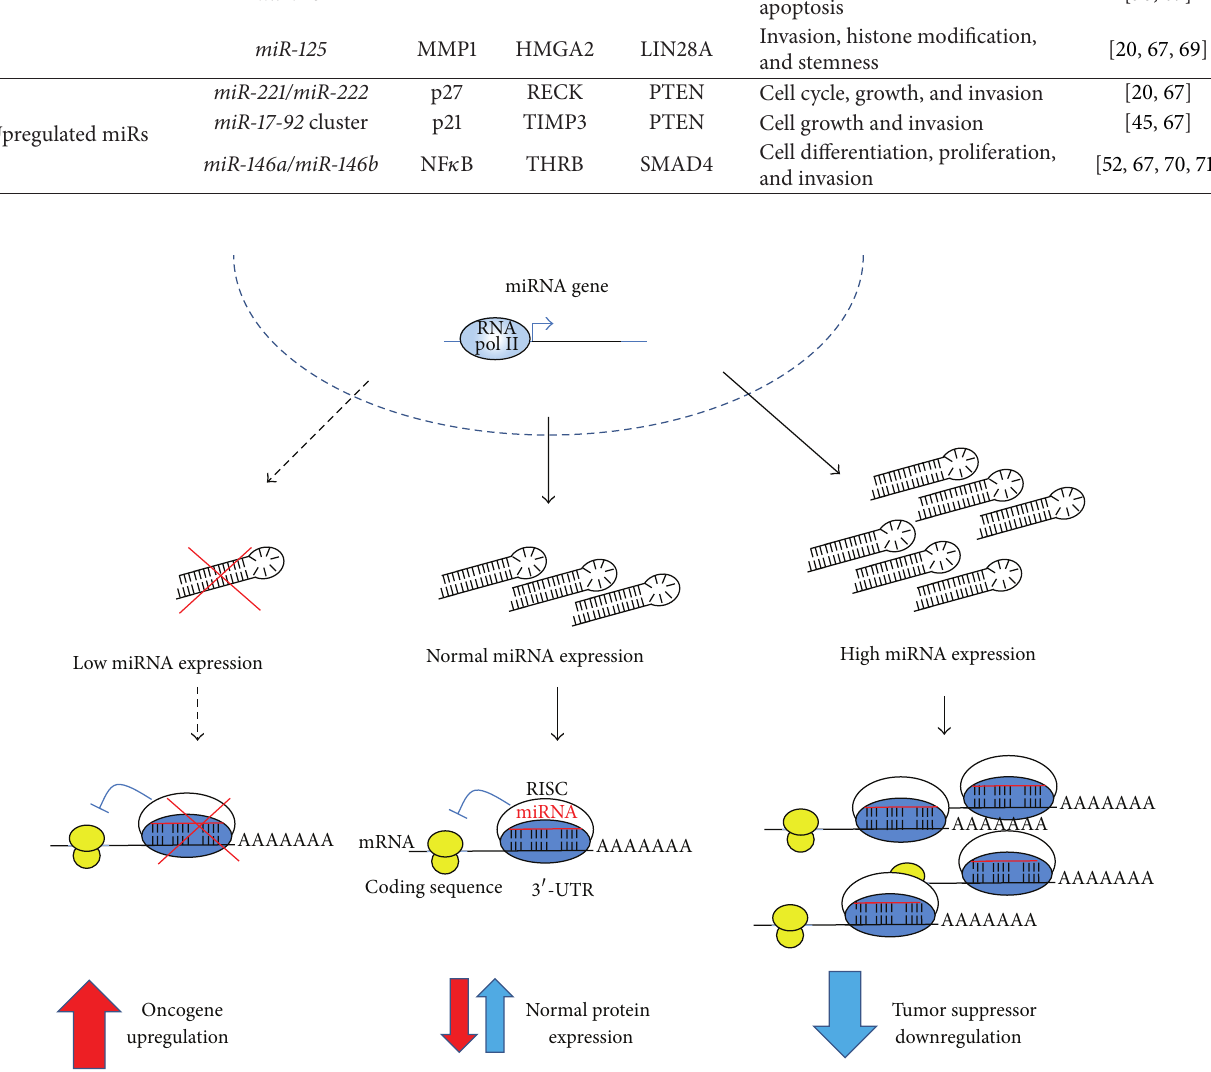
Figure 2: Some miRNAs act as oncomiRs. Deregulation of miRNA changes physiological protein level balances and enhances the oncogenic process where (1) low expression of an miRNA may enhance protein translation of an oncogenic protein or (2) high expression of an miRNA may repress the translation of a tumor suppressor gene. Both situations may occur concomitantly in cancer as observed in anaplastic thyroid